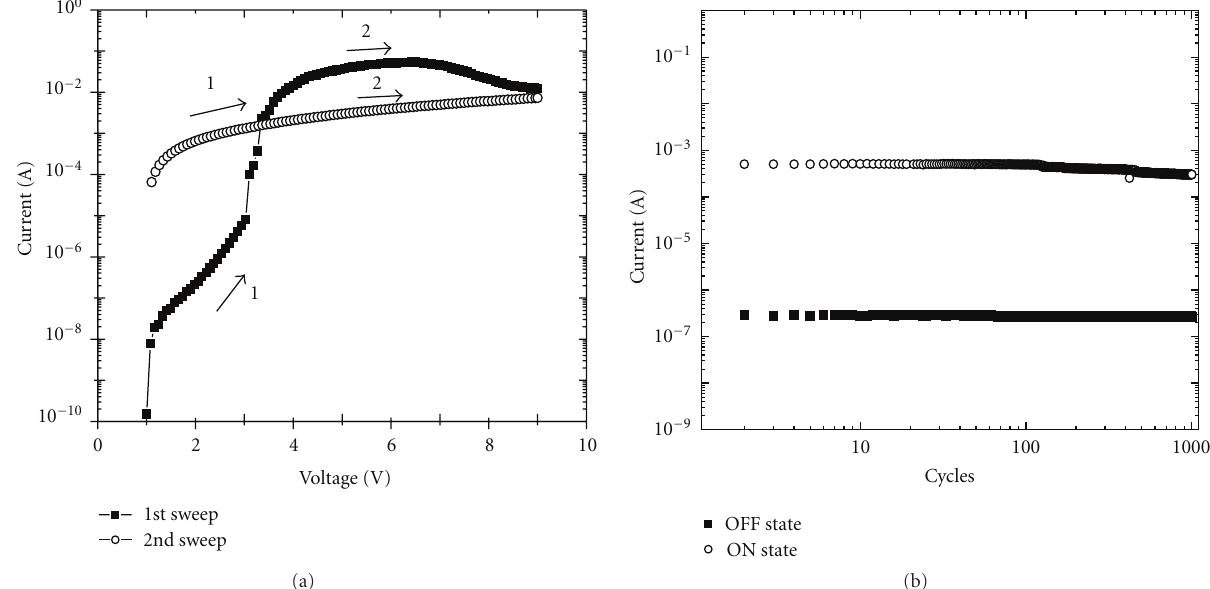
Figure 3: (a) I-V curve of an Al/PMMA (22nm)/Al device. PMMA was dissolved with CB. (b) E ff ect of the read cycles on the stability of the On and O ff states. The read voltage was set at 1V.